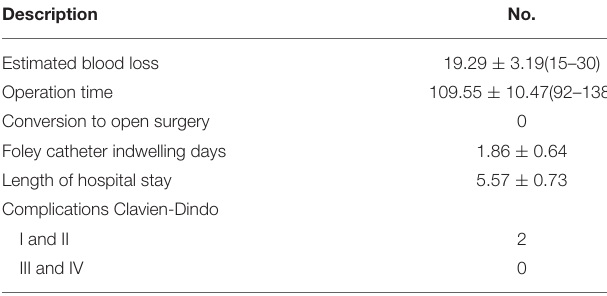
TABLE 2 | Perioperative outcomes.